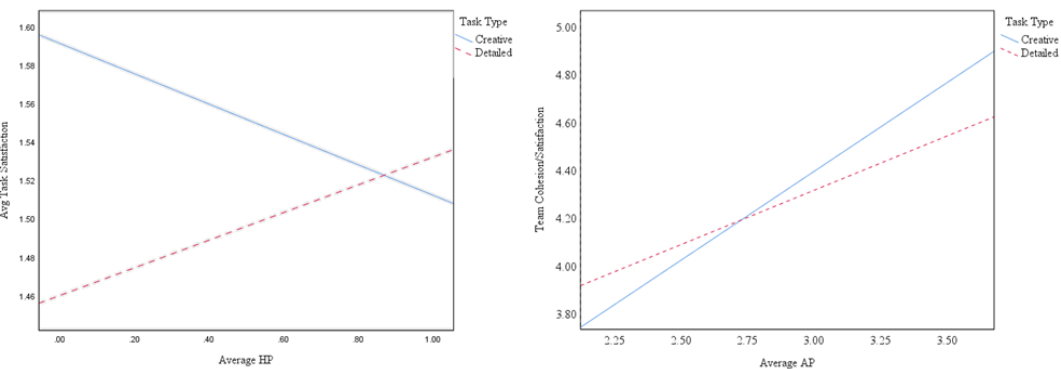
Figure 1. Moderation of task type on authentic pride’s relationship with team cohesion/satisfaction (Left) and moderation of task type on hubristic pride’s relationship with task satisfaction (Right).